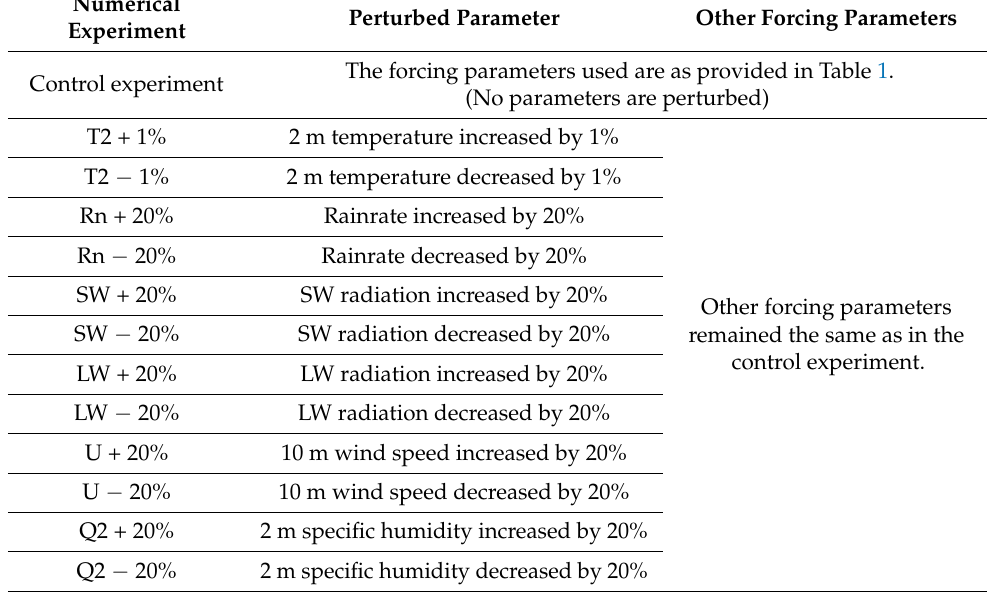
Table 2. Numerical experiment